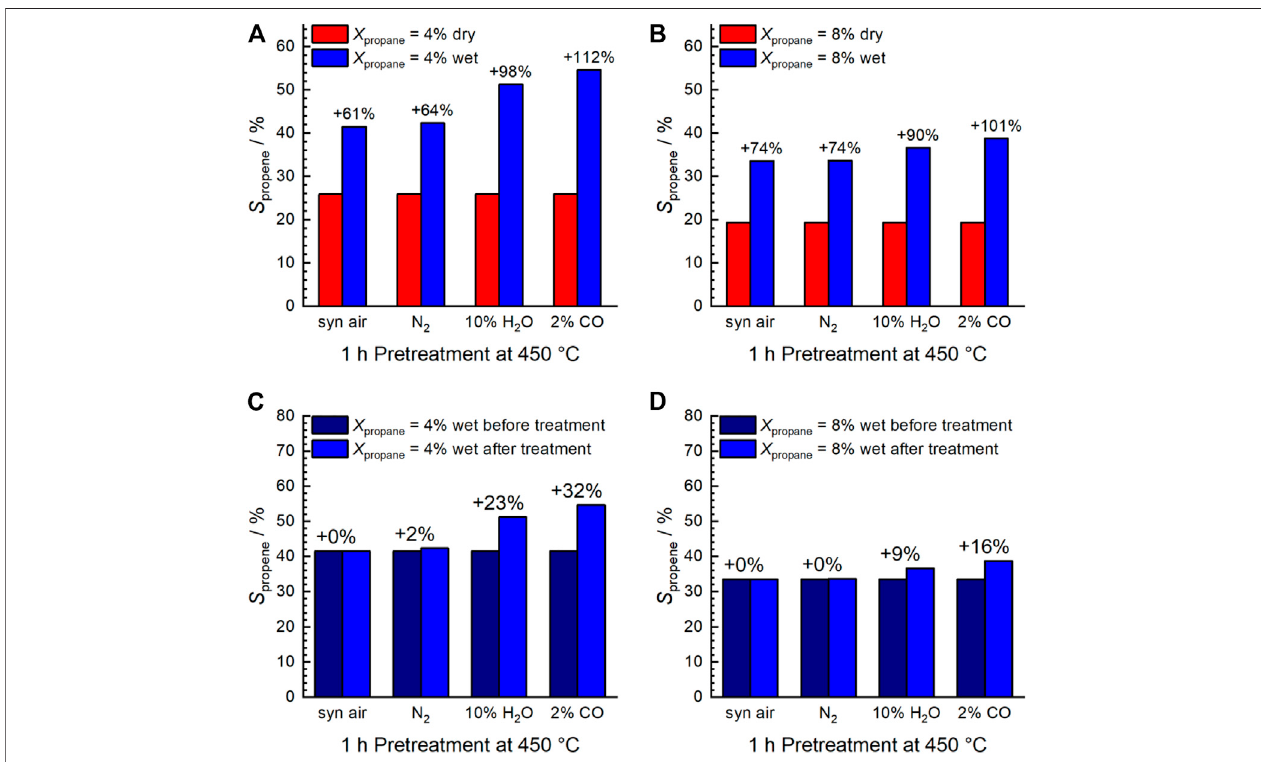
FIGURE2 | Selectivityto propene shown at thesameconversion ofpropane: 4% (A,C) and 8% (B,D) .Comparison between dry and wet feed (A,B) and initial wet feed(aftercalcinationinairat450 ° C)andwetfeedafterthedifferenttreatments (C,D) .C 3 H 8 /O 2 /inert (cid:2) 5/10/85(dryfeed);C 3 H 8 /O 2 /inert/H 2 O (cid:2) 5/10/45/40(wetfeed);F/ W (cid:2) 0.29 L min − 1 · g − 1 ; T (cid:2) 300 ° C. The numbers above the columns indicate the respective increase in